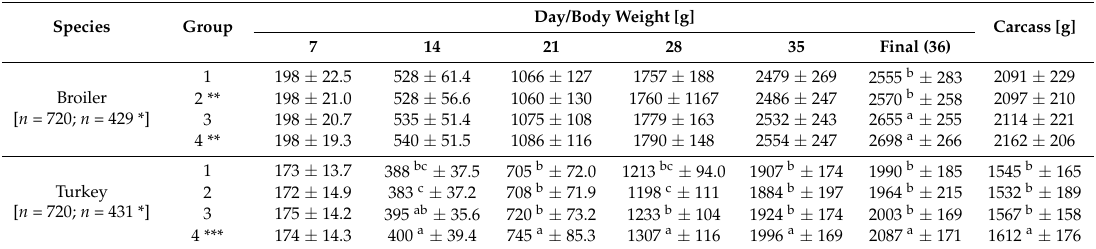
Table 2. Development of body weight in fattening broilers and turkeys reared on different floor designs (mean ±